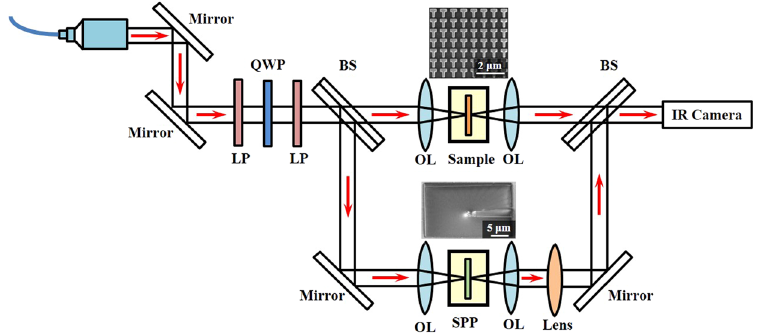
Figure 2. Experimental setup of the optical vortex based spiral interferometry for directly characterizing the phase retardation through the metasurface sample of T-shaped antenna array. LP: linear polarizer, QWP: quarter-wave plate, BS: beam splitter, OL: objective lens, SPP: spiral phase plate (with the perspective-view SEM image shown in the lower